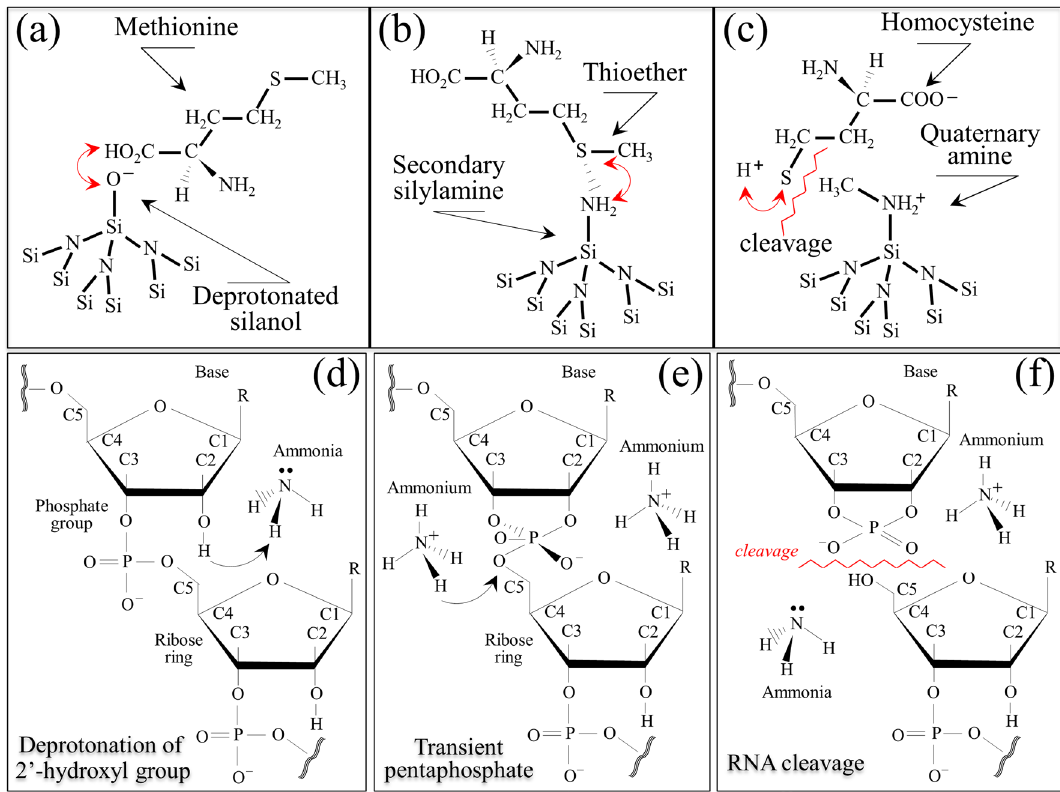
Figure 10. ( a ) Attraction by deprotonated silanol groups at the surface of Si 3 N 4 toward the C-COOH terminus of methionine; ( b ) formation of hydrogen bond at the thioether with hydrogen bond acceptor silylamine sites on the Si 3 N 4 surface; and, ( c ) bonding of secondary silylamines to carbon of the methionine methyl group CH 3 to form a quaternary amine with positive charge, while releasing a homocysteine molecule in the environment. In the lower panels, the process of genome degradation by alkaline transesterification through hydrolysis of RNA phosphodiester bond: ( d ) deprotonation of the 2 ′ -hydroxyl group by ammonia base; ( e ) formation of transient pentaphosphate unit; and, ( f ) interaction with acidic ammonium leading to RNA fragmentation by